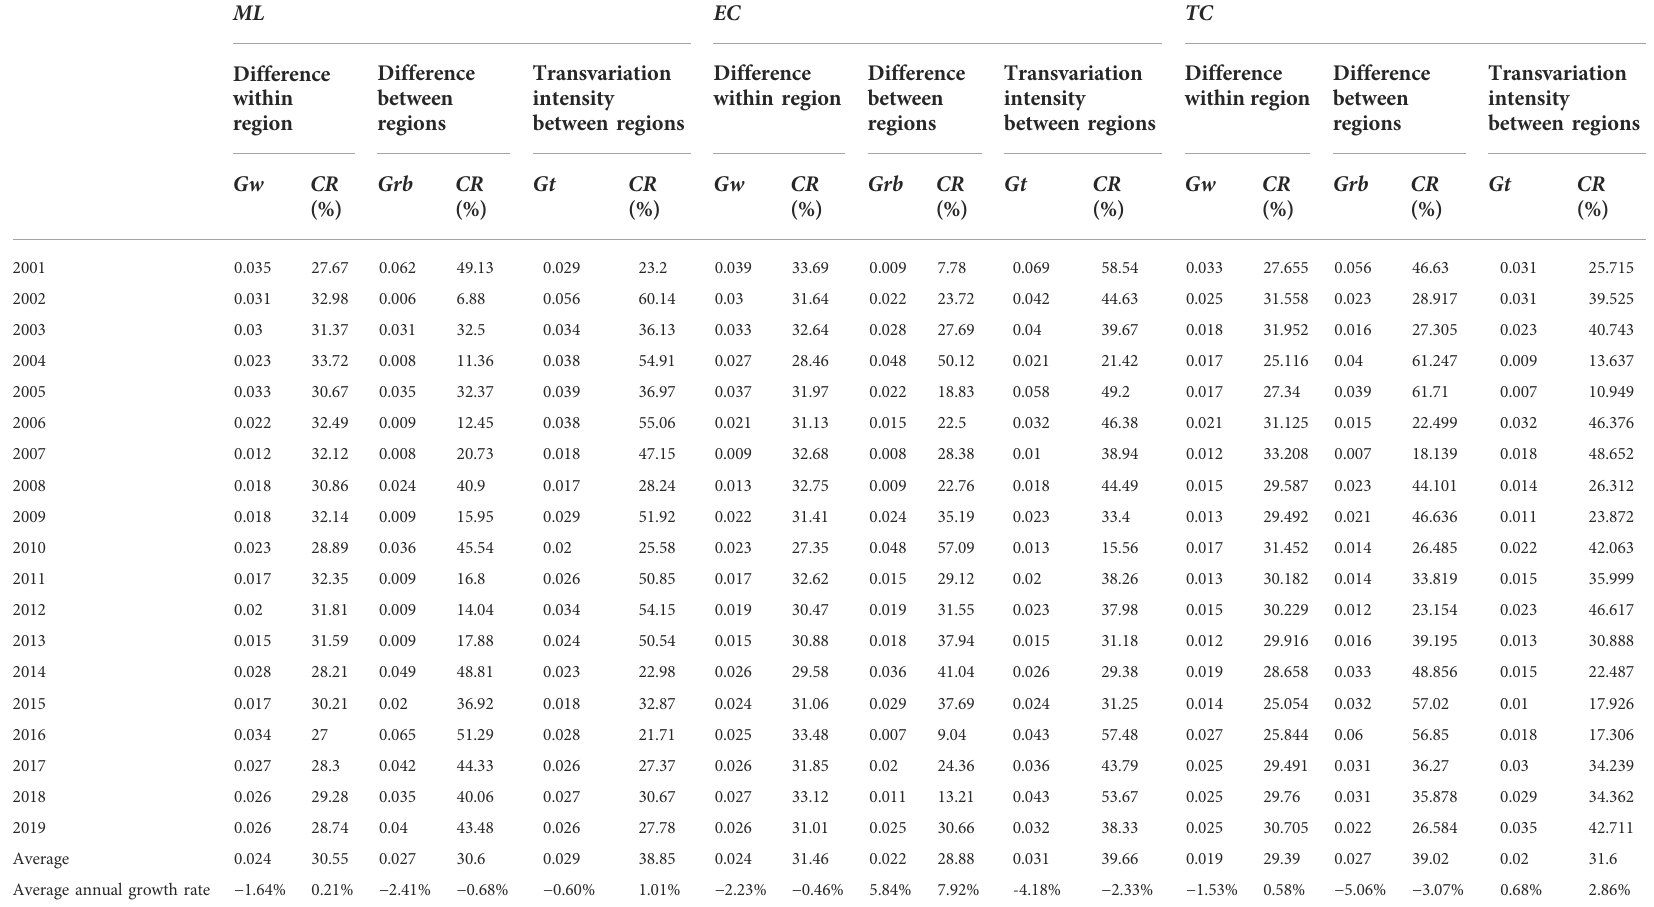
TABLE 5 The contributions to the total difference of